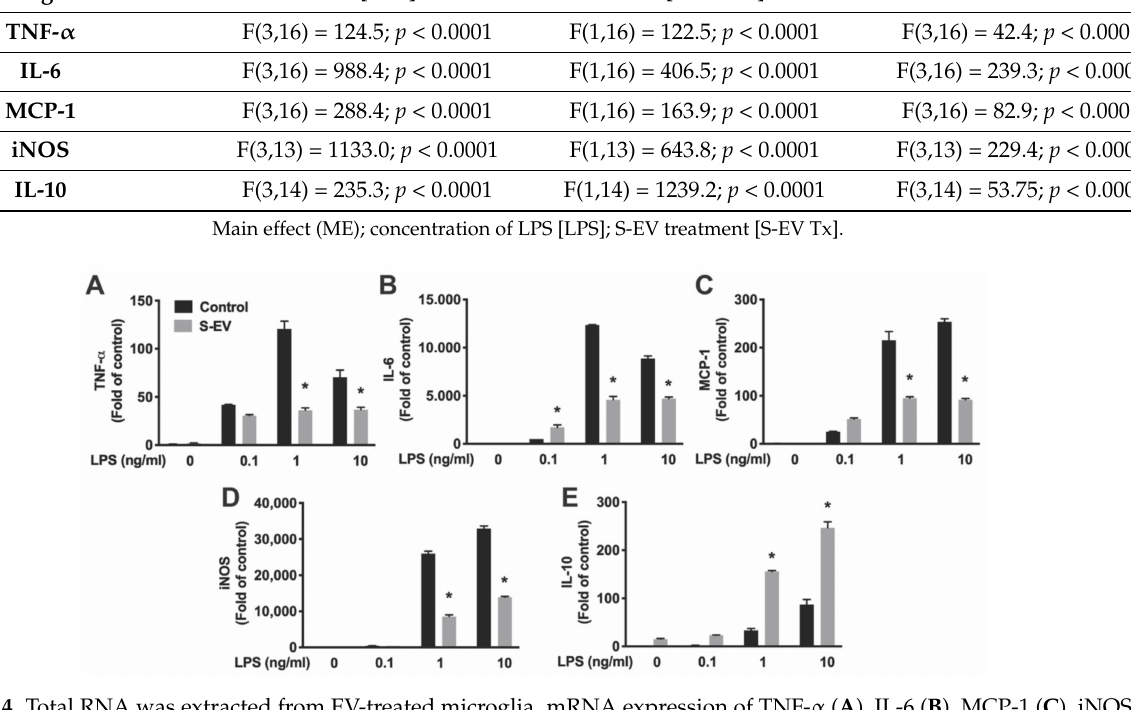
Figure 4. Total RNA was extracted from EV-treated microglia. mRNA expression of TNF- α ( A ), IL-6 ( B ), MCP-1 ( C ), iNOS ( D ) and IL-10 ( E ) was determined by real-time RT-PCR and presented as folds of control. PCR was run in triplicate and data were presented as mean fold of control ± SD. Data represented three independent experiments and was analyzed by ANOVA. Statistics are listed in Table 3. * p < 0.05 versus respective control with LPS.